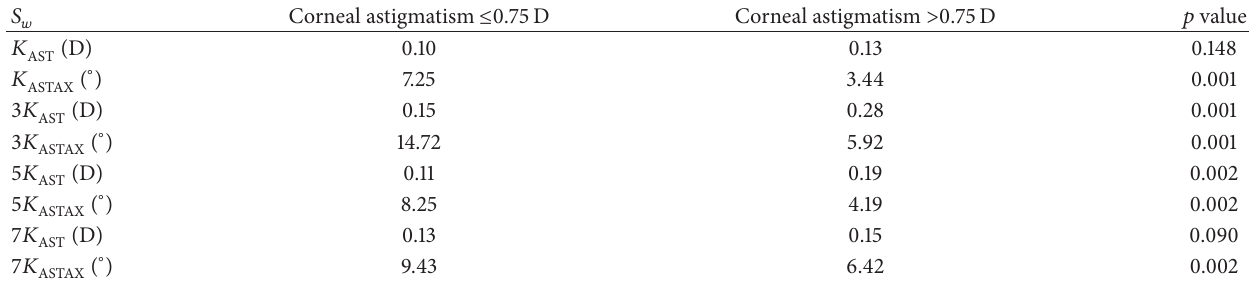
Table 2: Summary of the intrasession repeatability outcomes for the corneal astigmatism and axis measurements obtained by means of the VX120 system depending on the magnitude of corneal astigmatism.